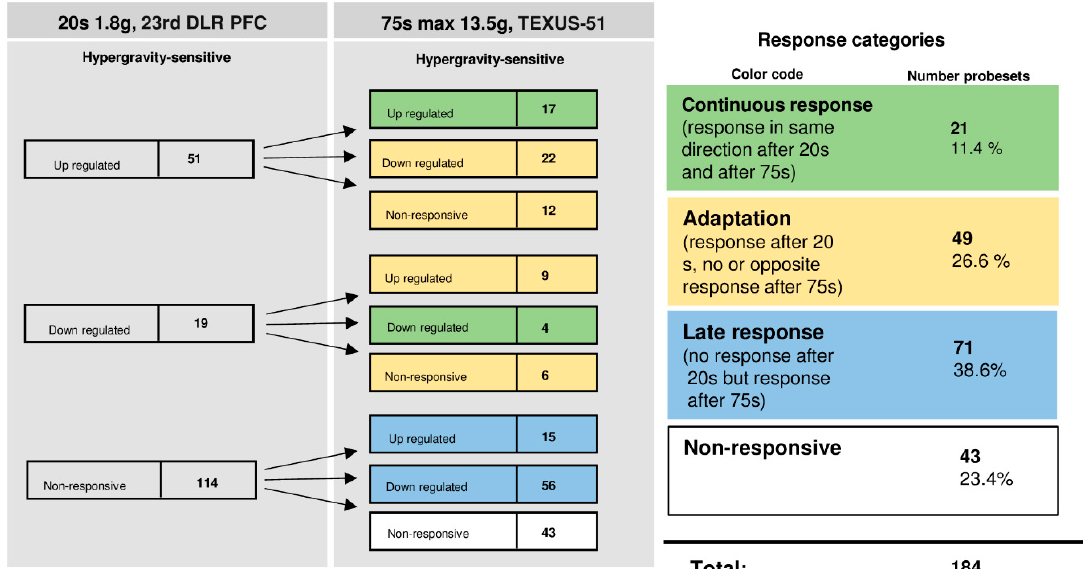
Figure 7. Time course of differential expression of 184 HIF-related probe sets in human Jurkat T cells after hypergravity exposure (list of probe sets in Supplementary Table S1). Human Jurkat T cells were exposed to 20 s and 75 s of hypergravity. The probe sets are grouped according to their regulation after the two exposure times. Continuous response means that the probe sets are either up-regulated or down-regulated at both time points. Adaptation is either the disappearance of the hypergravity-induced effect or regulation in the opposite direction after 75 s. Late response is a regulation that only appears after 75 s. Most of the probe sets show a late response. For the abbreviations of the experiment group names see Table 1. Table 6. Differentially regulated probe sets in a continuous manner in 20 s and 75 s of hypergravity identified in human Jurkat T cells in the 23rd DLR parabolic flight and TEXUS-51 suborbital ballistic rocket campaigns; 21 probe sets, belonging to 21 genes were differentially regulated with respect to both altered gravity platforms. Plus: significantly up-regulated probe sets ( p -value < 0.05), minus: significantly down-regulated probe sets ( p -value < 0.05). FCs are ratios between the averages of linear expression values. If the ratio is <1, FC is calculated as the negative reciprocal of the ratio. For the abbreviations of the group names see Table 1.